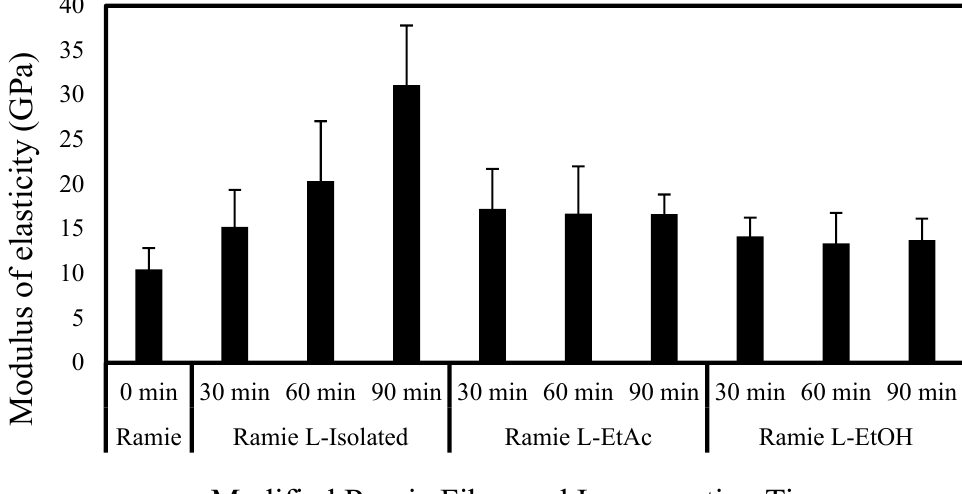
Figure 11. Variation of the modulus of elasticity (MOE) of modified ramie fiber.